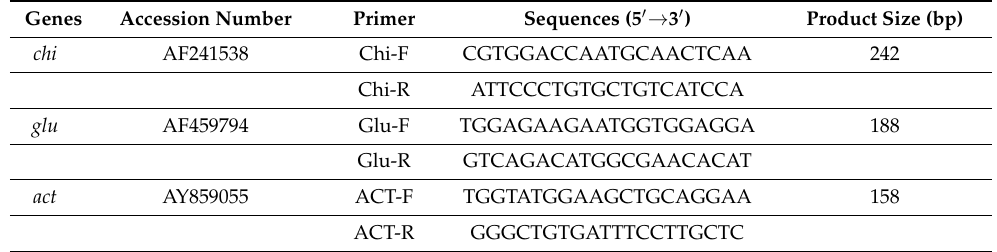
Table 1. Specific primer pairs for the gene expression determinations with reverse transcription quantitative polymerase chain reaction